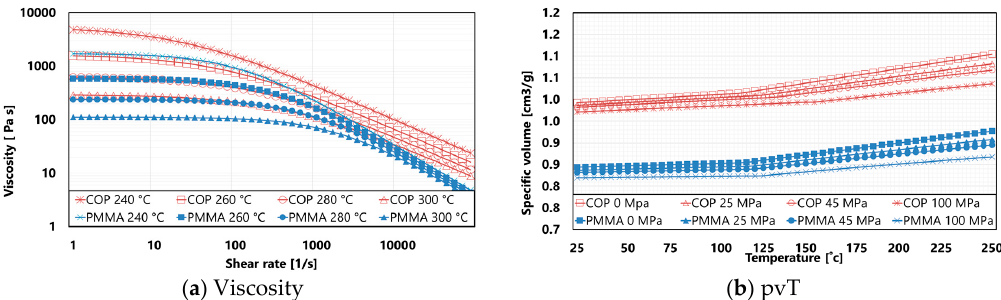
Figure 3. Cyclo-olefin polymer (COP) and polymethyl methacrylate (PMMA) material properties: ( a ) shear rate-dependent viscosity at different temperature values; ( b ) temperature-dependent specific volumes at different pressure values. Data collected from the Moldflow ® software database, version 2018, by Autodesk ® (San Rafael, CA, USA).